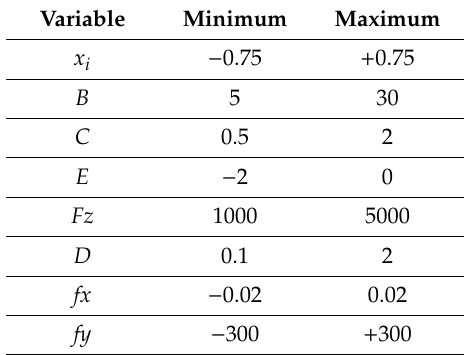
Table 1. Range of values for MF model parameters.